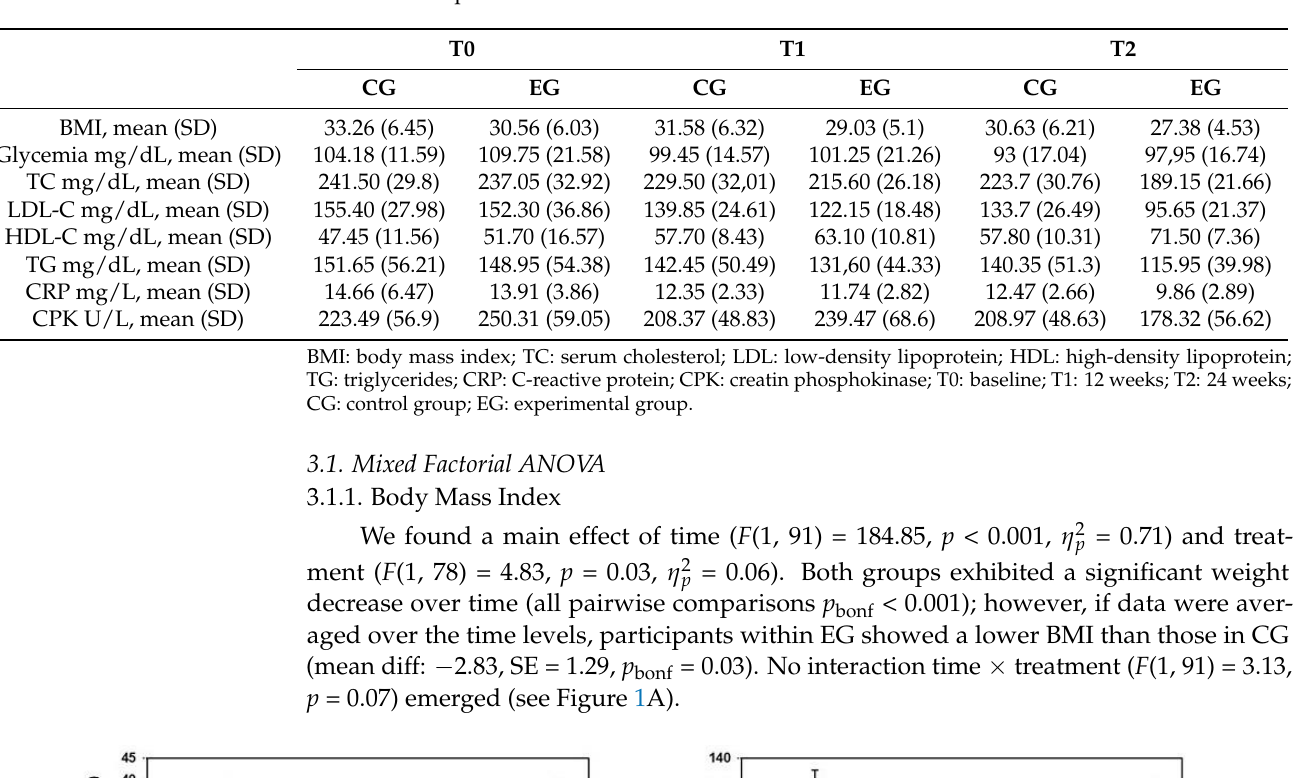
Figure 1. Line plots representing the results from mixed factorial ANOVAs on biochemical param- eters in experimental group (EG) and control group (CG): ( A ) BMI, ( B ) glycemia, ( C ) total choles- terol, ( D ) LDL-cholesterol, ( E ) HDL-cholesterol, ( F ) triglycerides, ( G ) C-reactive protein, and ( H ) creatine phosphokinase. Note . * p < 0.001, ◊ p < 0.01, ○ p < 0.05; a T0 – T2 for both groups, p < 0.05. 3.1.2. Glycemia A main effect of time ( F (1, 86) = 11.63, p = 0.001, 𝜂 𝑝2 = 0.13) was observed, with glyce- mia levels decreasing over time in both groups. Conversely, no main effect of group ( F (1, 78) = 2.20, p = 0.14) or time×treatment interaction effect ( F (1, 86) = 0.36, p = 0.57) were shown (see Figure 1B). 3.1.3. Serum Total Cholesterol Levels We found a main effect of time ( F (1, 111) = 170.60, p < 0.001, 𝜂 𝑝2 = 0.69), treatment ( F (1, 78) = 8.13, p = 0.006, 𝜂 𝑝2 = 0.09), and a significant interaction between time and treat- ment ( F (1, 111) = 37.46, p < 0.001, 𝜂 𝑝2 = 0.32). Specifically, both groups exhibited a signifi- cant decrease in serum total cholesterol levels over time (all pairwise comparisons p bonf <